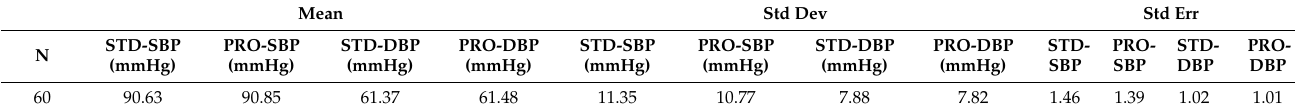
Table 2. The descriptive statistics of the blood pressure for both systolic and diastolic results.